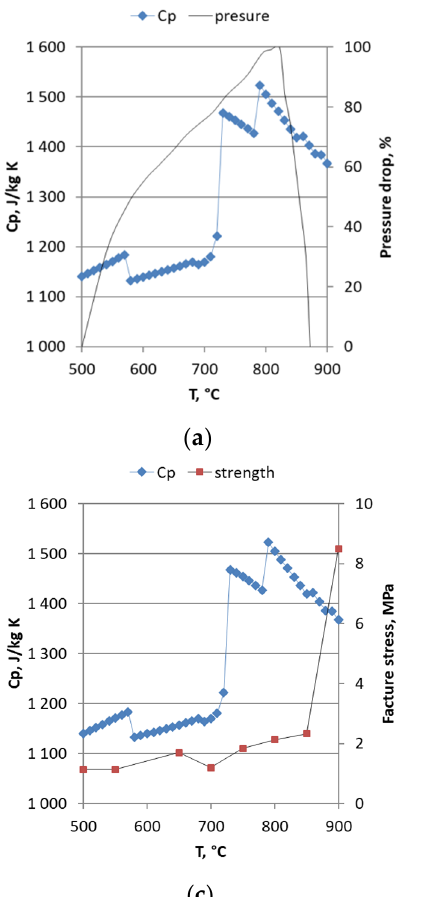
© ( d ) Figure 12. Bituminous coal: ( a ) Specific heat (c p ) and pressure drop as a function of temperature; ( b ) density (  ) and pressure drop as a function of temperature; ( c ) specific heat and fracture stress as a function of temperature; ( d ) density and fracture stress as a function of temperature.